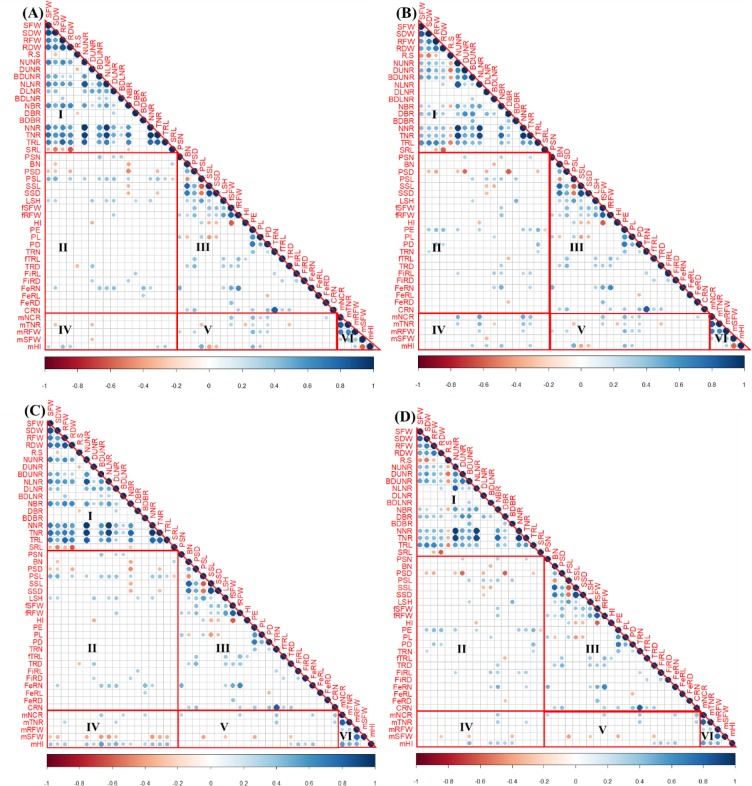
Phenotypic correlations between traits observed in cassava plants grown in soil-filled pots for 30 or 45 days after planting (DAP) and in the field for 7 or 12 months.A: correlations between traits measured in 30-DAP-pot grown, 7-months plants and 12-months-field grown plants in 2017; B: correlations between traits measured in 45-DAP-pot grown, 7-months plants and 12-months-field grown plants in 2017; C: correlations between traits measured in 30-DAP-pot grown plants, 7-months plants and 12-months-field grown plants in 2018; and D: correlations between traits measured in 45-DAP-pot grown plants, 7-months plants and 12-months-field grown plants in 2018. In each panel, I, II, III, IV, V and VI are correlations between traits measured in 30/45-DAP plants; 30/45-DAP and 7-months plants; within traits of 7-months plants; 30/45-DAP plants and 12-months plants; 7 and 12-month plants; and within traits of 12-months plants, respectively. Full names of traits shown in the matrix are can be found in Tables 1–4. Size and colour of circles within the matrix indicate the magnitude of correlation. The scale is indicated in the bar below the matrix. Blank boxes indicate non-significant relationships (p< 0.05).